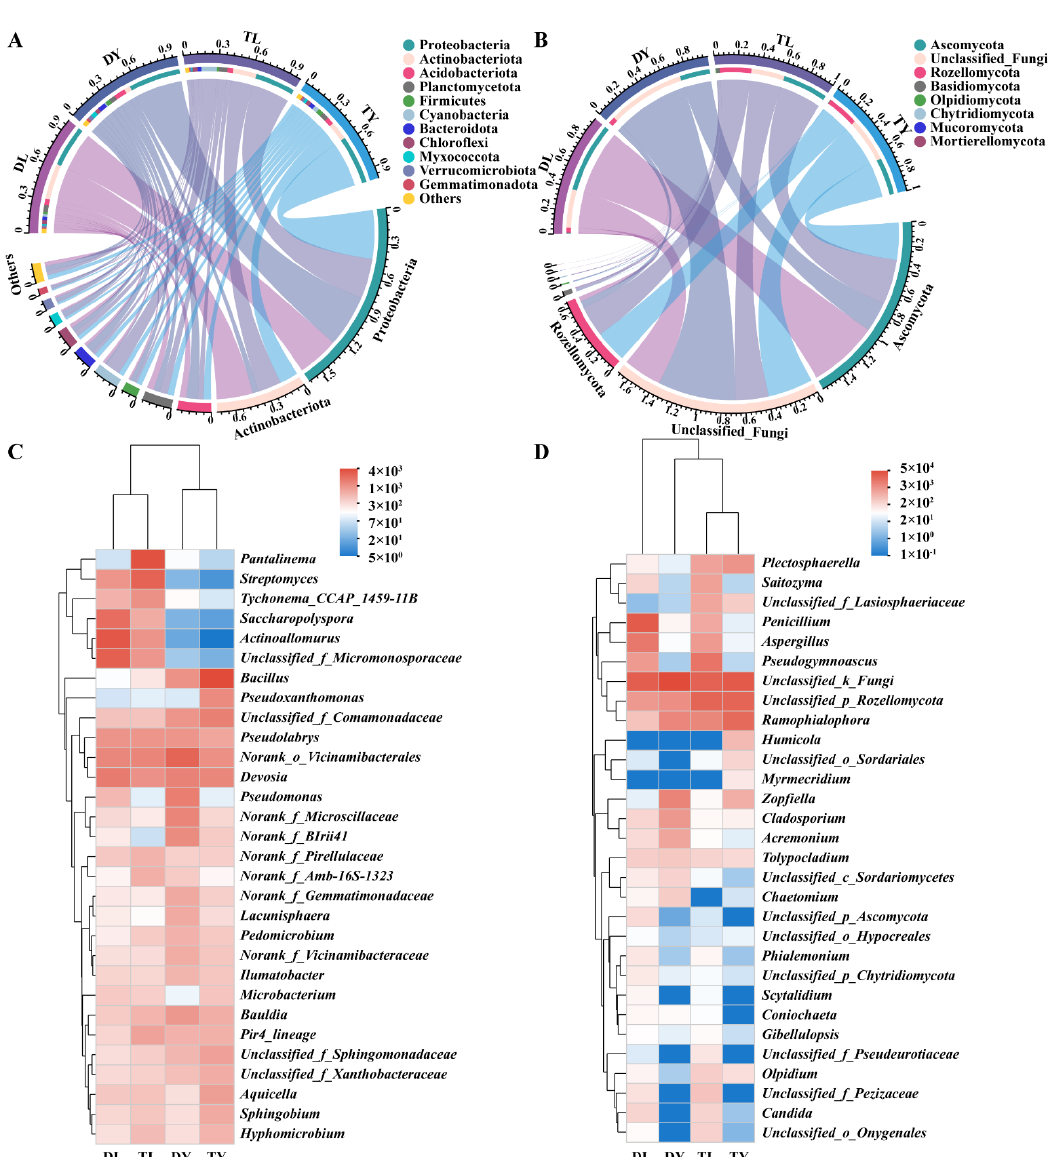
Figure 2. Microbial community structure of the soilless growing media. ( A ) Circus analysis for bacteria at phylum level; ( B ) circus analysis for fungi at phylum level; ( C ) hierarchically clustered heatmap for bacteria at genus level; ( D ) hierarchically clustered heatmap for fungi at genus level. Data show as mean value. The same below. 3.3. Effects of Environmental Parameters on Microbial Community under Different Treatments To reveal the correlation between environmental parameters and primary genera, correlation network analysis was performed based on Spearman’s correlation coefficients ( p < 0.01). As shown in Figure 3A,B, the urease, phosphatase, OM and ω were significantly